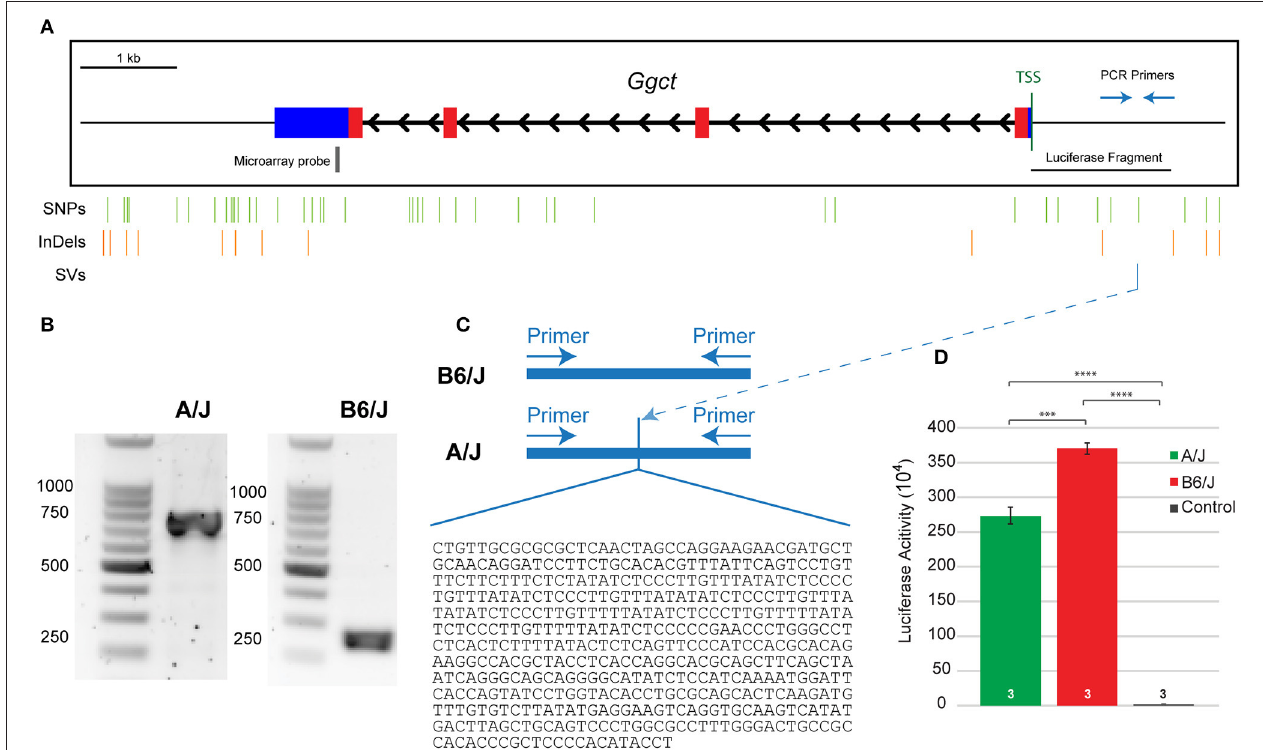
FIGURE 6 | (A) The Ggct gene contains four exons (colored boxes) and three introns (black arrowheads). Blue boxes represent 5 ′ and 3 ′ untranslated regions while thin black lines indicate 2kb upstream and downstream regions. The position of all single nucleotide polymorphisms (SNPs), short insertions and deletions (InDeLs), and structural variants (SV) that discriminate the parental strains are indicated with vertical lines. Location of PCR primers used in (C) , microarray probe used in Figures 4A,B , and the luciferase fragment tested in (D) are also shown relative to the TSS. (B) The amplified fragment was roughly 500 bp larger in the A/J strain. (C) The insertion in A/J was sequenced and confirmed to be 478 bp in size. Nucleotide sequence is listed 5 ′ -3 ′ . (D) An in vitro luciferase expression assay confirmed that both promoter sequences were effective in driving gene expression, relative to the control condition, but that there was significantly reduced luciferase expression in the presence of the A/J promoter. n = the number of biological replicates analyzed per condition. The entire experiment was subsequently replicated twice, obtaining the same significant differences between groups (not shown). *** p < 0.001; **** p <